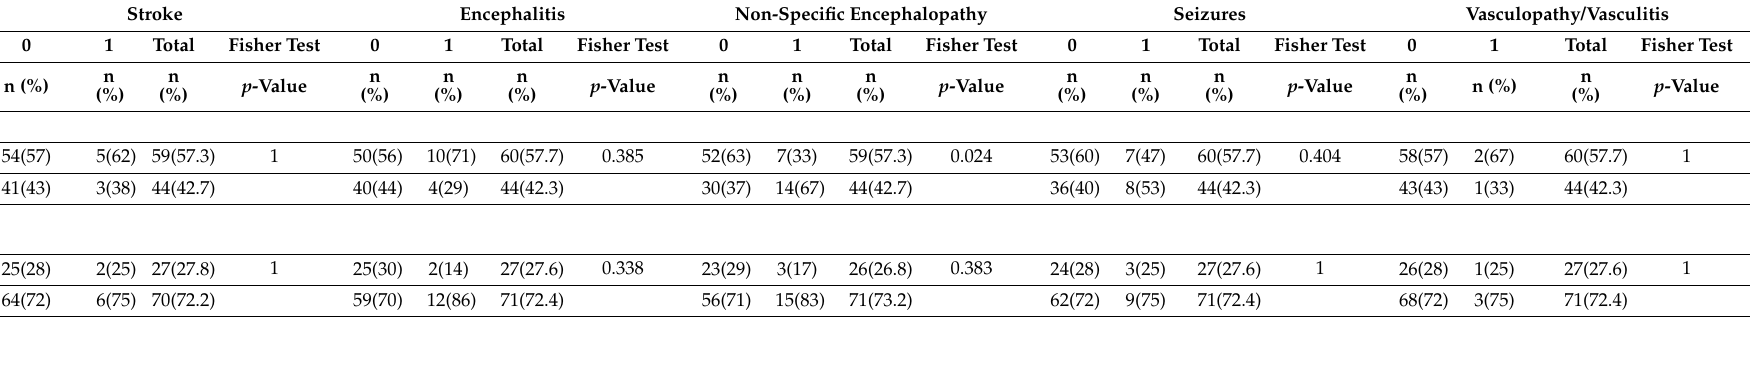
Table 2. Comparison of various CSF markers and demographics, severity and fatality by CNS manifestation. Stroke Encephalitis Non-Specific Encephalopathy Seizures